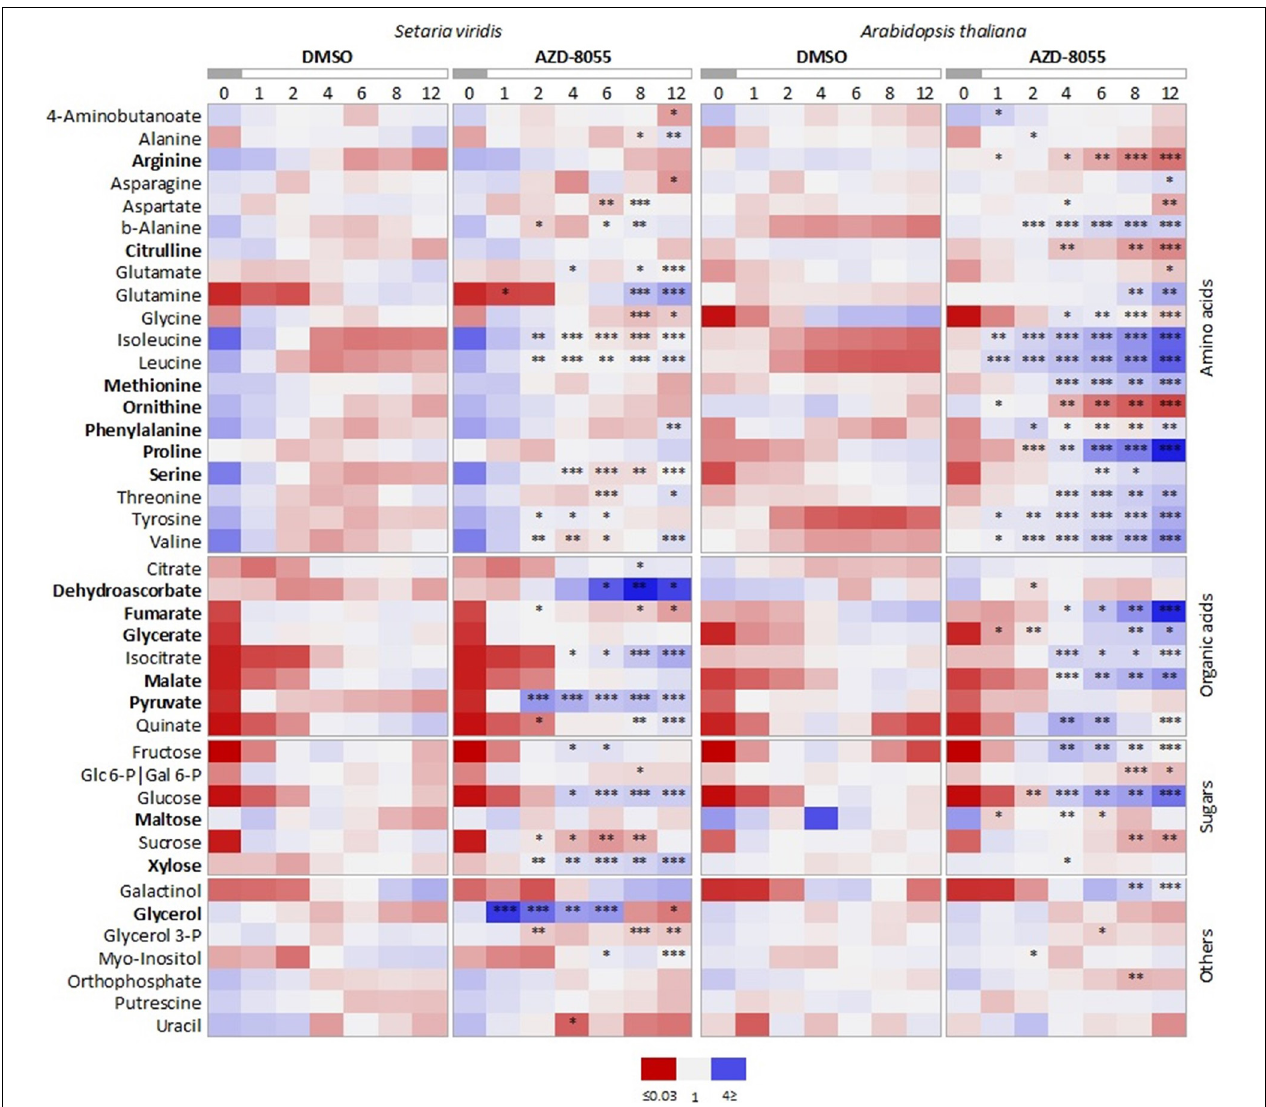
FIGURE 4 | Comparative heatmap of metabolic changes in S. viridis and A. thaliana seedlings under TORC inhibition. Seedlings were grown hydroponically under 12 h photoperiod until specific and compatible developmental stages before application of DMSO 0.05% (control), 10 or 2 µ M AZD8055 ( S. viridis and A. thaliana , respectively). Metabolite profiling was carried out using GC-TOF-MS. Data represents the average of biological replicates ( n = 5), median scaled, and normalized log 2 -transformed values. Significant differences between metabolites from control and TOR-inhibited seedlings are indicated by asterisks (Student’s t- test): ∗ P < 0.05, ∗∗ P < 0.01, and ∗∗∗ P < 0.001, and also available on Supplementary Dataset 3 . Metabolites in bold indicate differential behavior in S. viridis and A. thaliana